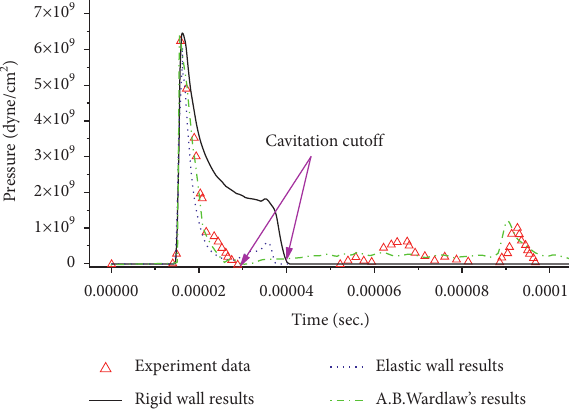
Figure 27: Pressure-time history at the inner center of deformable